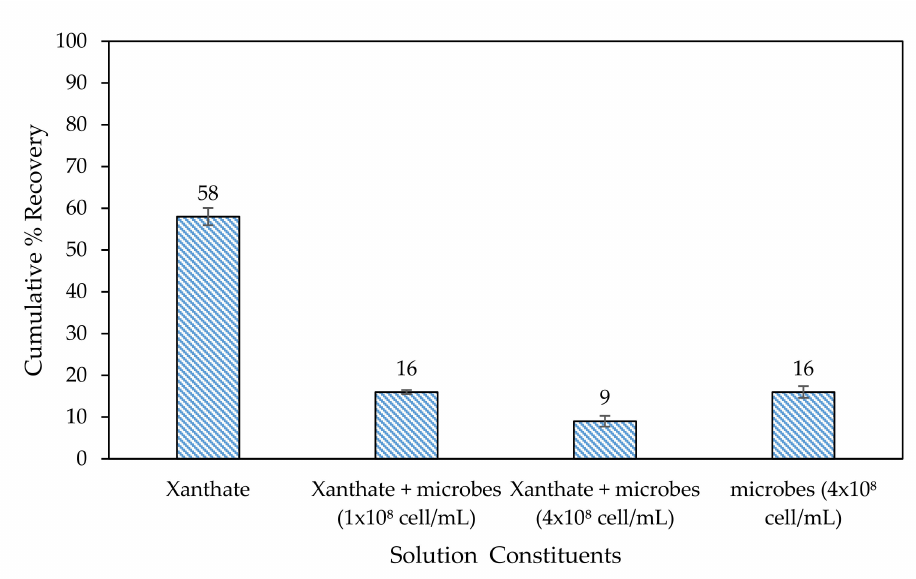
Figure 6. Galena cumulative recoveries in the presence of a 50% pseudo-monolayer SEX coverage and microbial cell counts of 1 × 10 8 cells / mL and 4 × 10 8 cells /